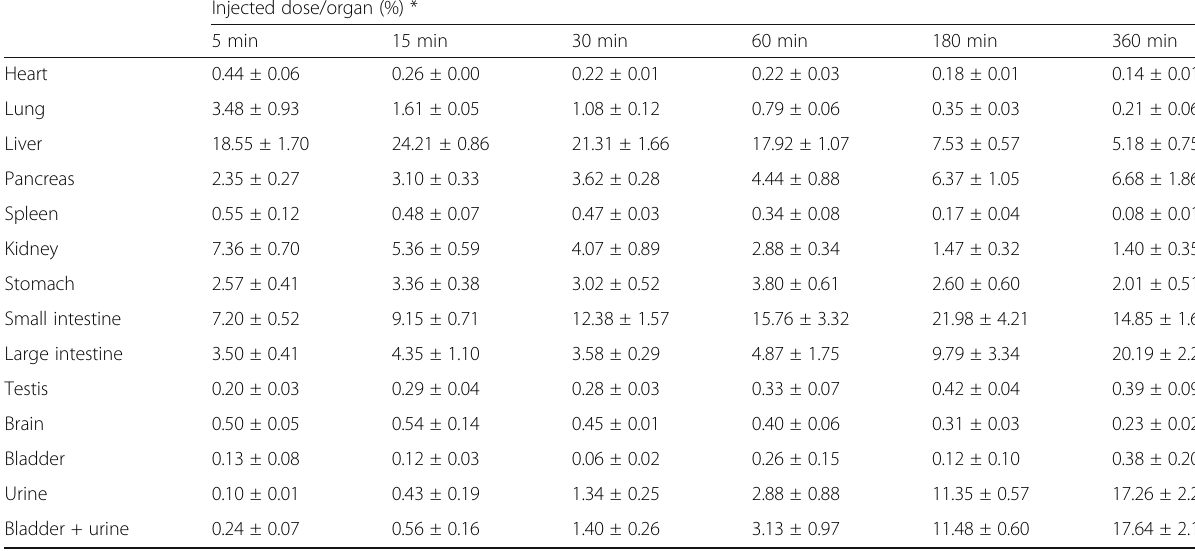
Table 4 Organ distribution of radioactivity in mice after intravenous injection of [ 18 F]MC225 Injected dose/organ (%)